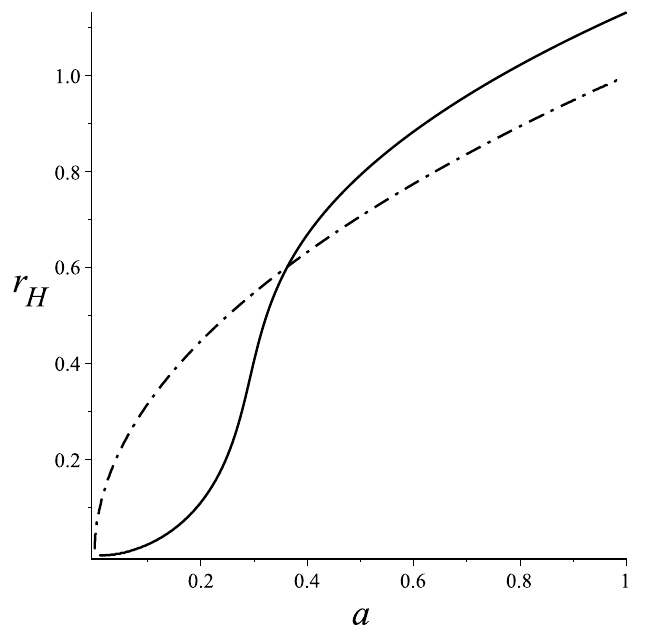
Figure 11 . The relation between r H and a when the temperature is 80% of the minimal AdS 5 - Schwarzschild value, shown, as in figure 8, with the line below which the black hole is unstable to a superradiant instability. Units are such that L = 1.